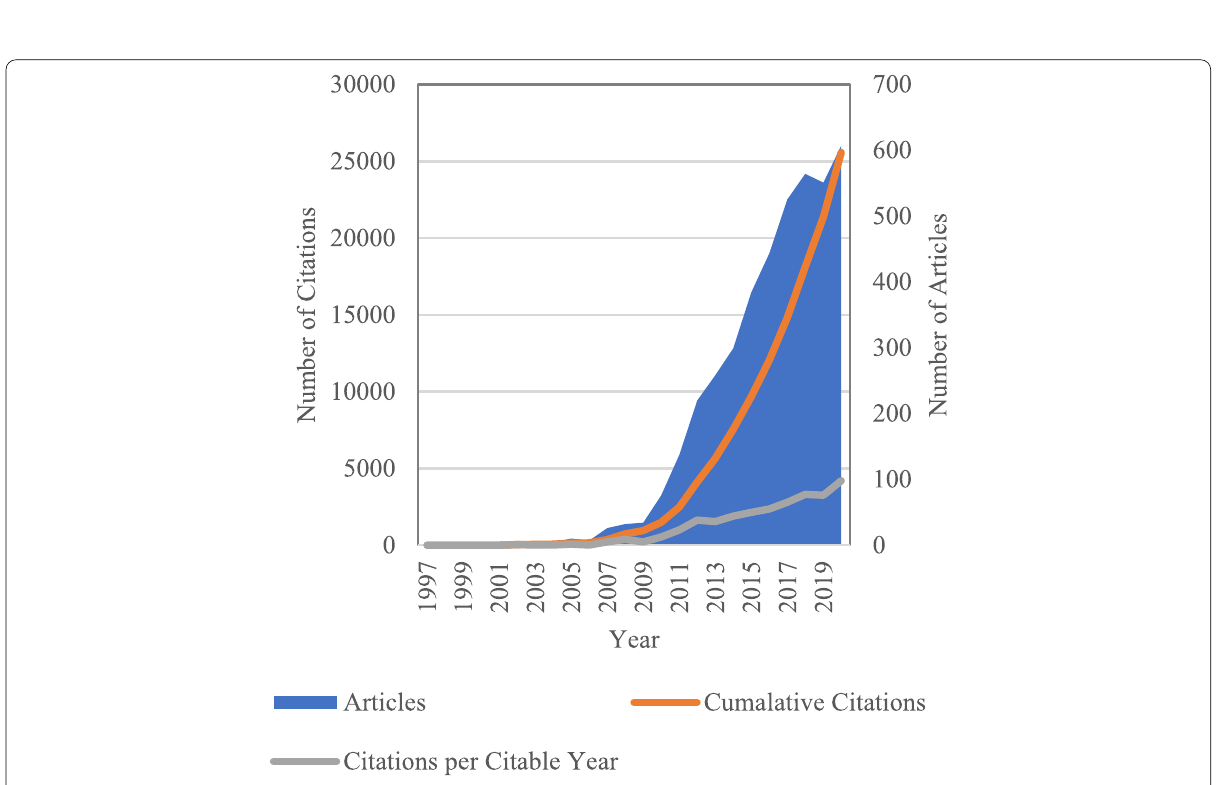
Fig. 11 Combined, productivity and